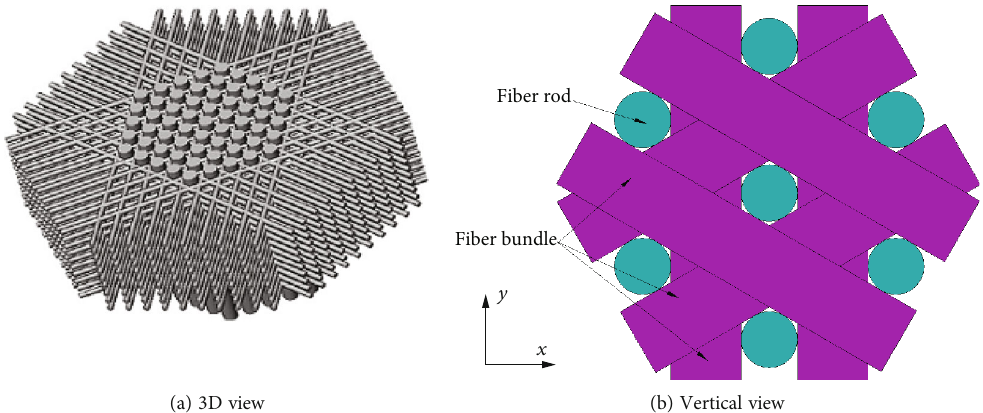
Figure 1: The scheme of the braided